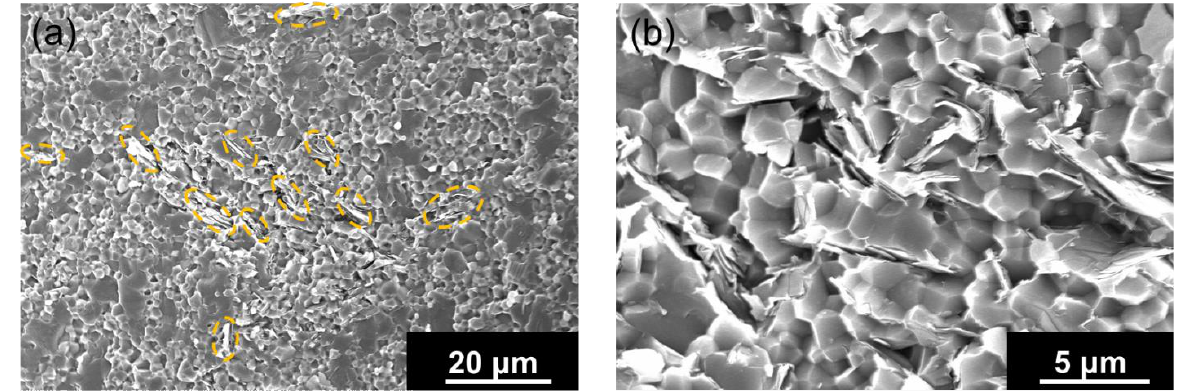
Figure 5. ( a ) The microstructure of the sintered artifact obtained using homogeneously hBN-incor- porated Al 2 O 3 composite granules, indicating the uniform hBN distribution (dotted circles) within the alumina matrix. ( b ) The high-magnification SEM image of an area with hBN sheets. The spark-plasma-sintered artifact obtained using Al 2 O 3 – hBN CS composite granules